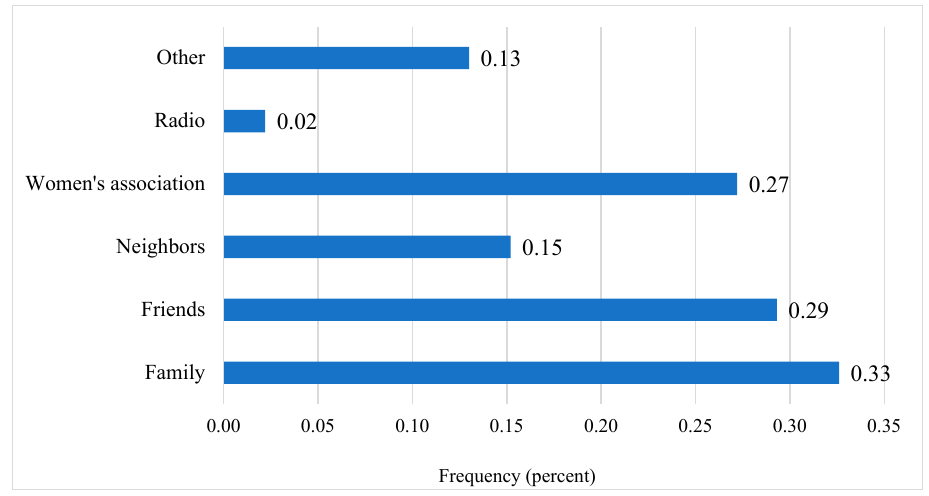
Figure 3. How Women Found Out About Processing or Retailing